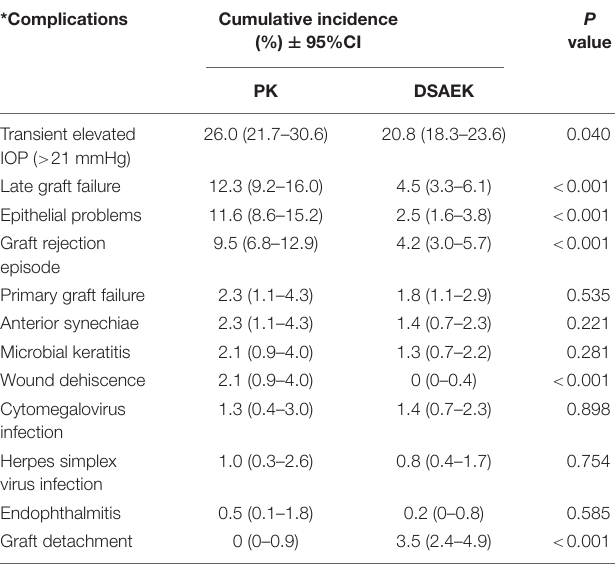
TABLE 3 | Ten-year cumulative incidence of complications comparing Descemet stripping automated endothelial keratoplasty (DSAEK) and penetrating keratoplasty (PK) in our study